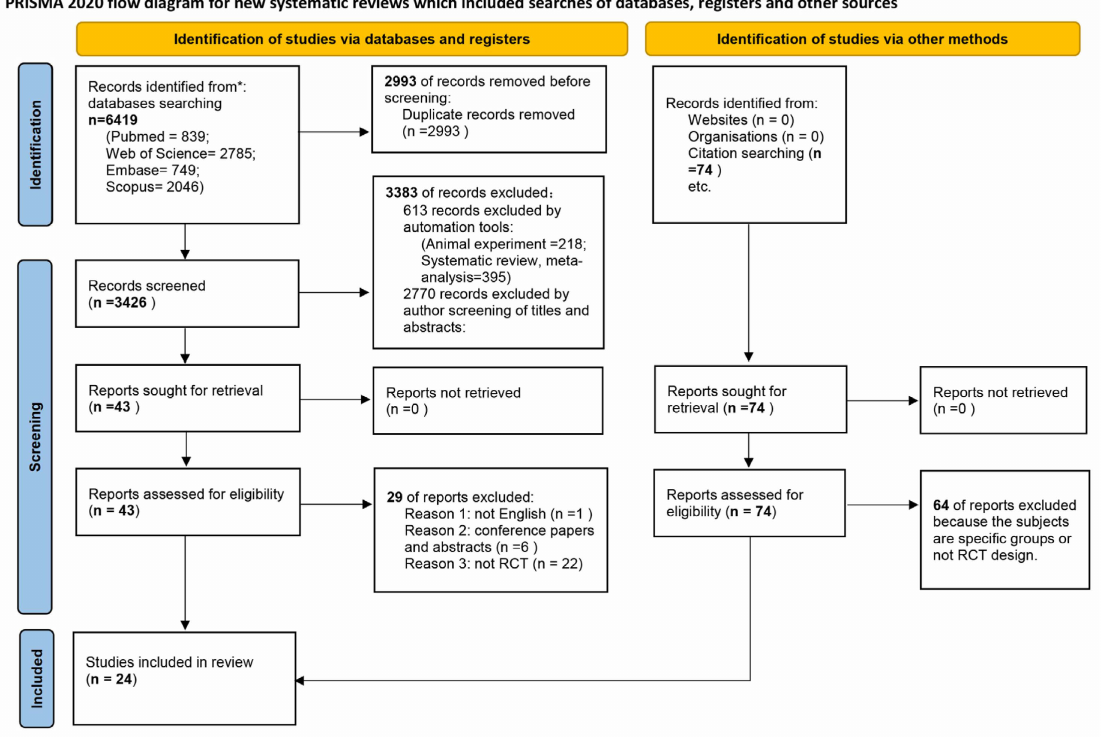
Figure 1. PRISMA 2020 flow diagram for the systematic reviews on the restorative benefits of exposure to green space. * According to the updated guideline from the PRISMA 2020 statement. Note: From